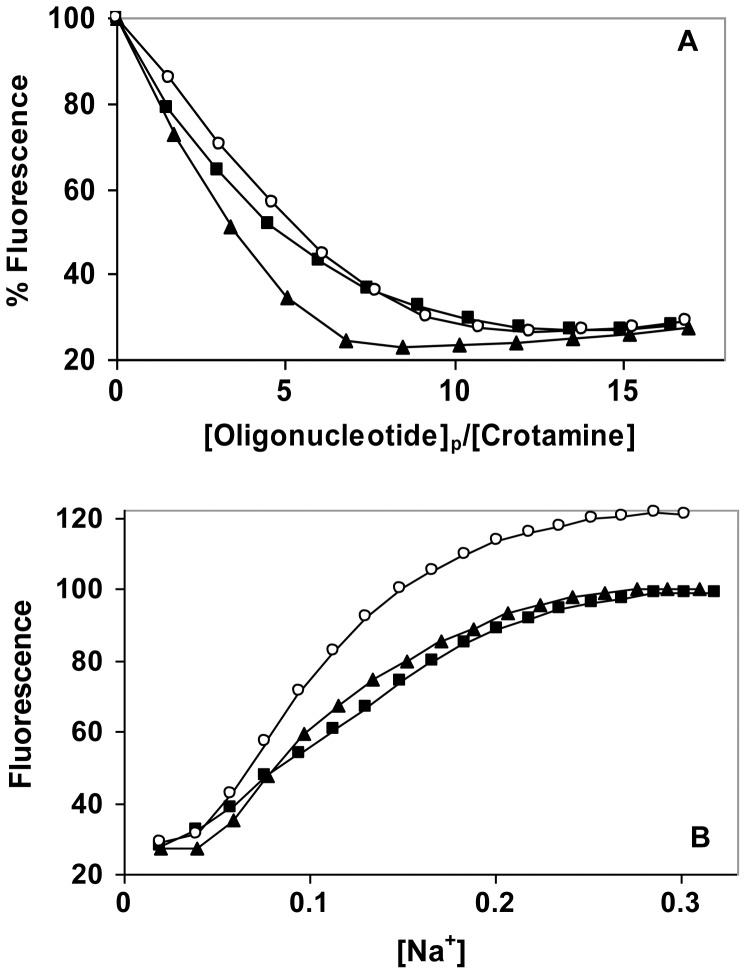
Effect of oligonucleotide length on binding affinity.A. Fluorescence titration in the standard buffer with 0.01 M NaCl: ▪, dT7; ▴, dT14, ◯, dT21. B. NaCl-induced reversal.